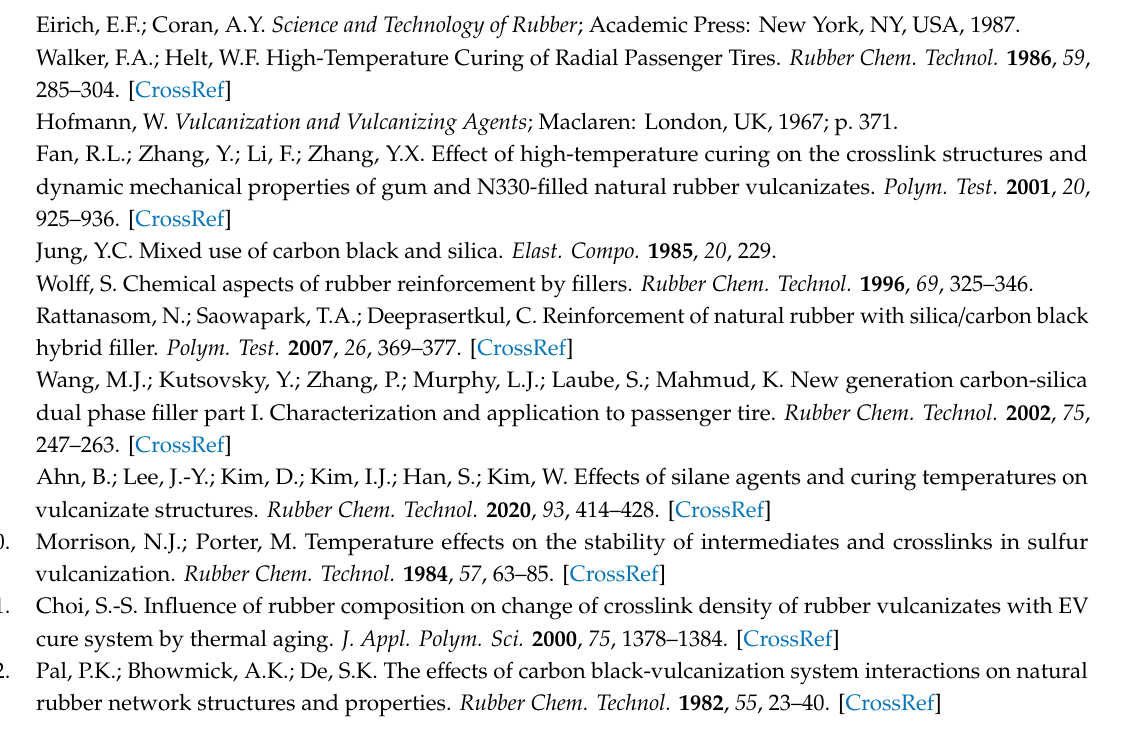
Table 8. E ff ect of silica-silane–rubber network (SSRN) or carbon black bound rubber (CBBR) on the performance change of rubber compounds with increasing cure temperature. Crosslink Item Cure Temp. Density